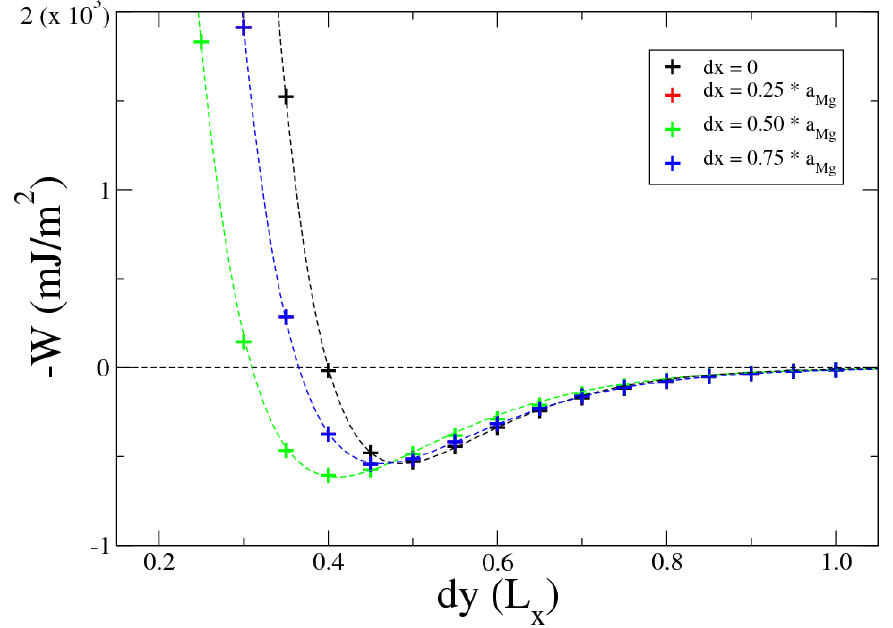
Table 2. Values yielded by regression fitting with Rydberg function of calculated values of work of adhesion (see Figure 4); dy 0 and l are expressed in unit of L